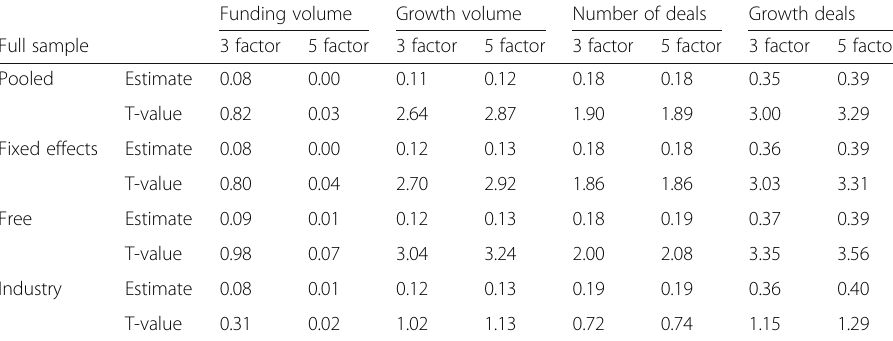
Table 3 Empirical